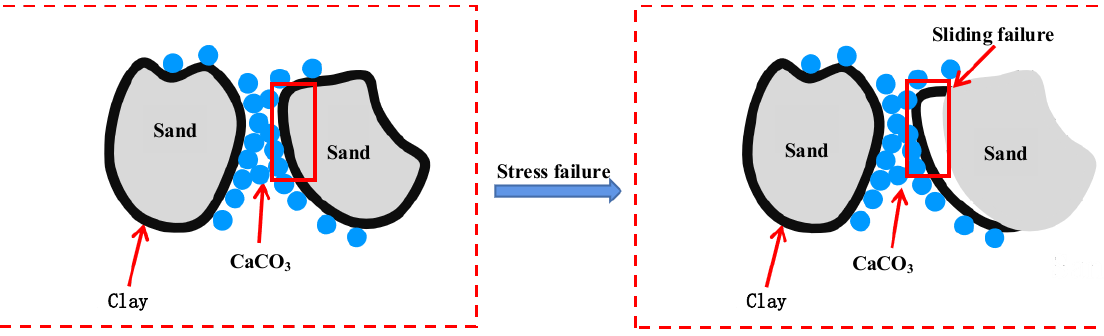
Figure 13. Sand-clay-CaCO 3 contact diagram.